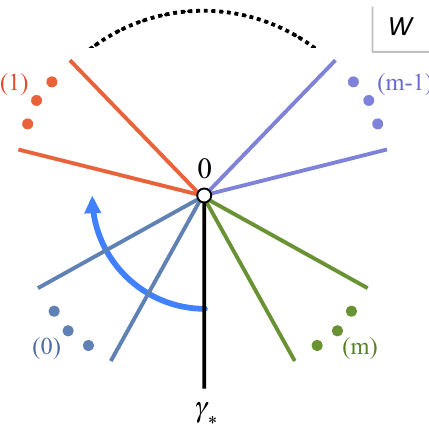
Figure 4. Duality as a geometric transition in the